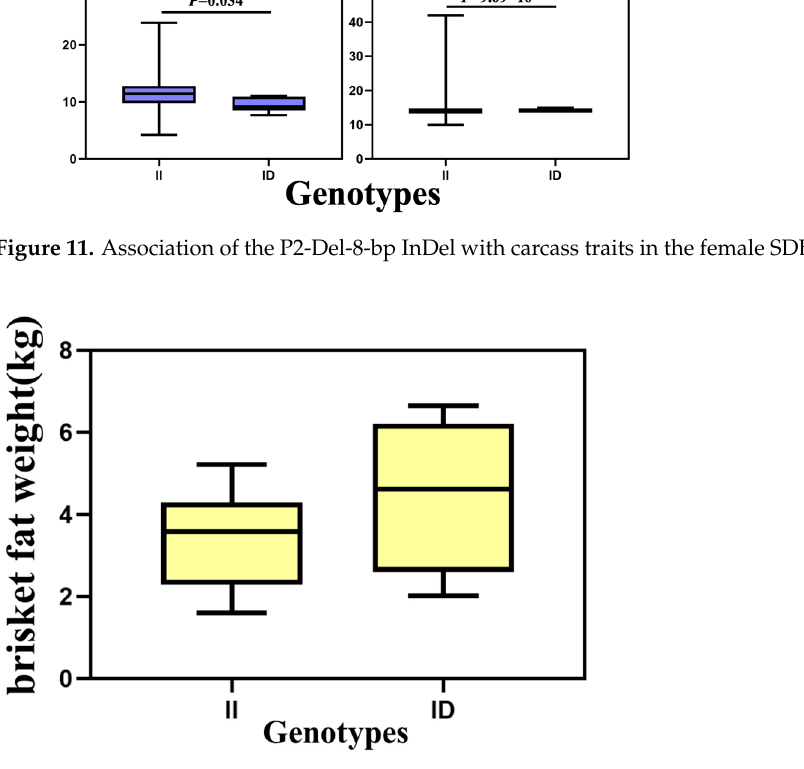
Figure 12. Association of the P2-Del-8-bp InDel with carcass traits in the male SDBCGR population. Table 6. Associations of the P1-Ins-4-bp InDel with carcass traits in the female SDBCGR population. Carcass